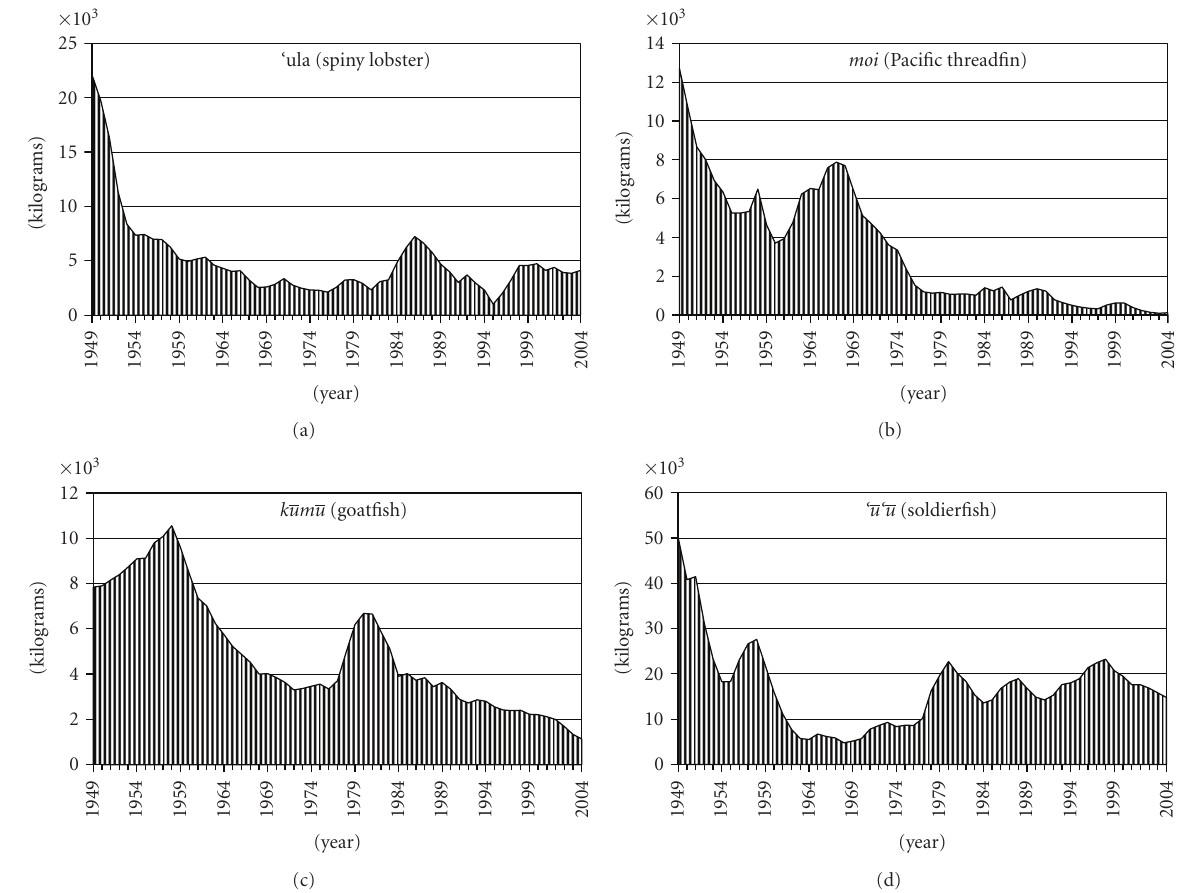
Figure 1: Main Hawaiian Islands commercial marine landings 1949–2005 for the ‘ula or spiny lobster ( Panulirus spp.), moi or Pacific threadfin ( Polydactylus sexfilis ), k¯um¯u or goatfish ( Parupeneus porphyreus ) and ‘¯u‘¯u or soldierfish ( Myripristis spp.). Data presented as 3yr. moving average. Source: Division of Aquatic Resources unpublished